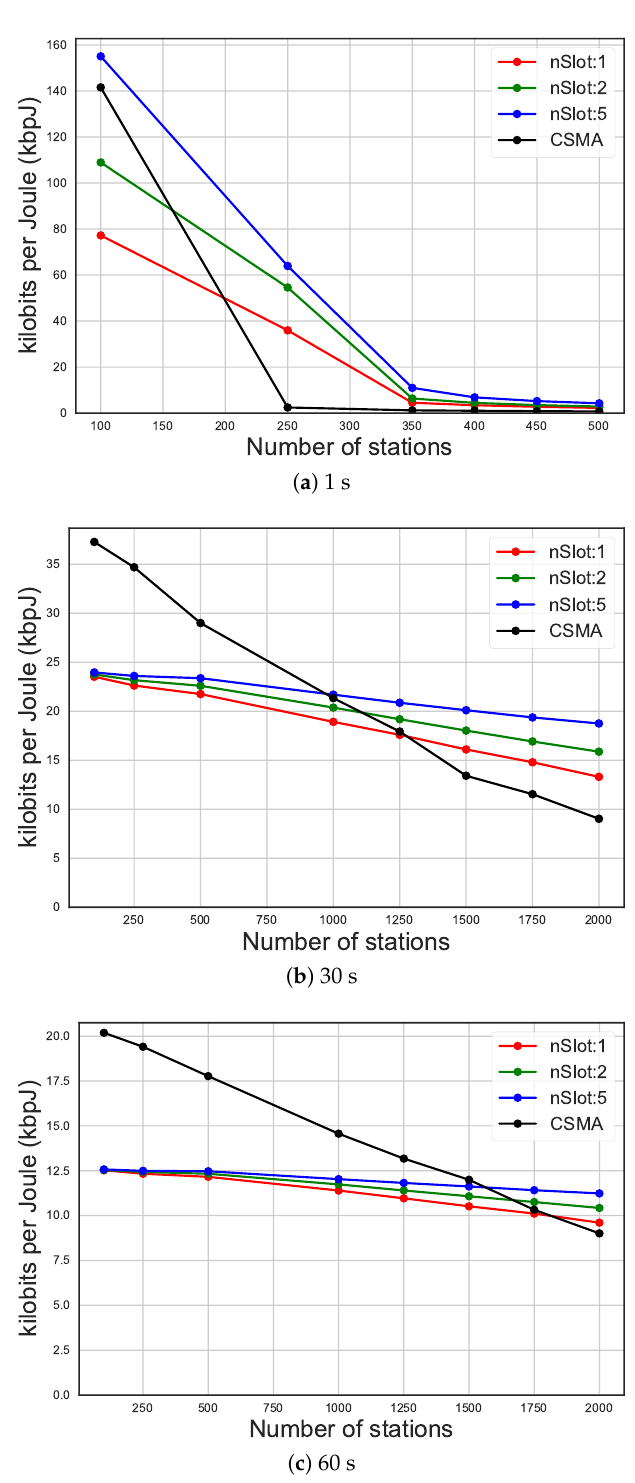
Figure 8. Energy efficiency of different packet arrival intervals, comparing carrier-sense multiple access with collision avoidance (CSMA/CA) and the usage of 10 RAW groups and one, two and five slots per